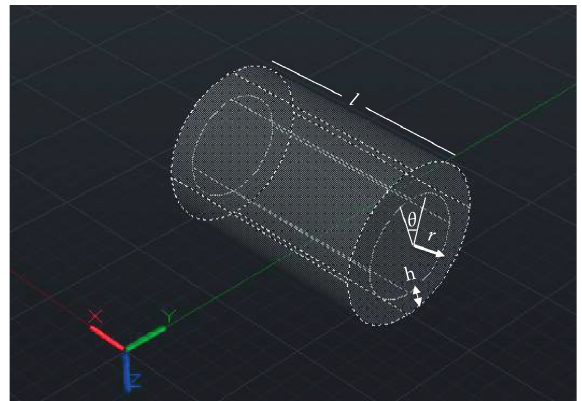
Figure 1: Cylindrical shell